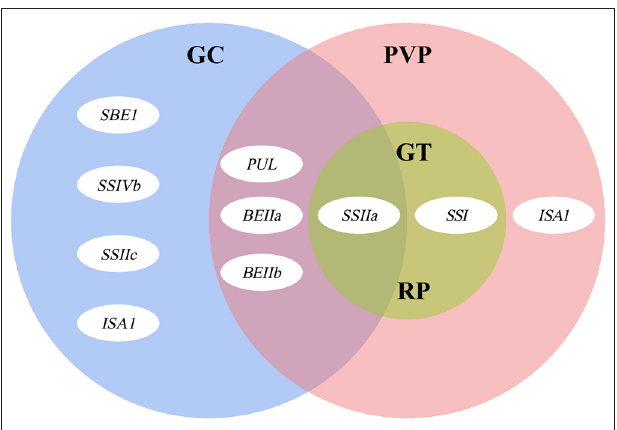
FIGURE 4 | The summary of genes controlling rice grain ECQs. The three large ovals represent gel consistency (GC, blue), pasting viscosity parameters (PVP, pink), gelatinization temperature (GT, green), and retrogradation properties (RP, green), and a small oval proportionally represents the role of each